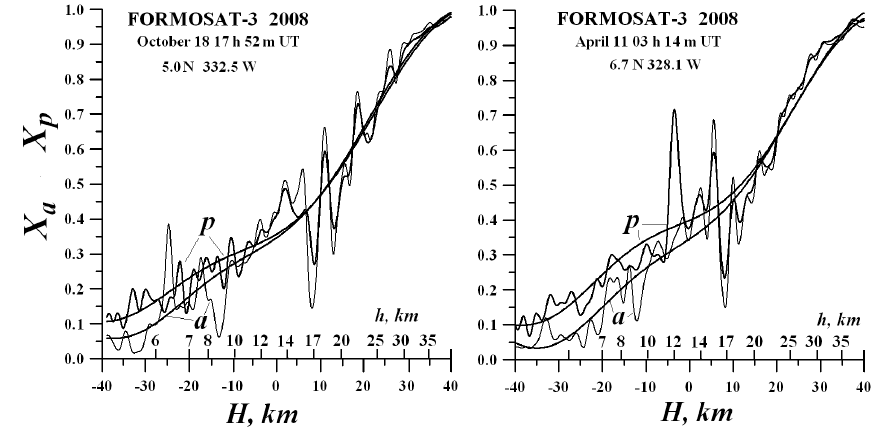
Figure 2. Comparison of the refractive attenuations X a (h) and X p (h) and their polynomial approximations, corresponding to the FORMOSAT-3 RO measurements carried out on 18 October and 11 April 2008 (left and right plots, respectively). Thick and thin rough curves (marked by indices “p” and “a”) describe the vertical profiles of X p (h) and X a (h) , respectively. Smooth curves describing polynomial approximations of the altitudes dependences of X p (h) and X a (h) are also highlighted by indices “p” and